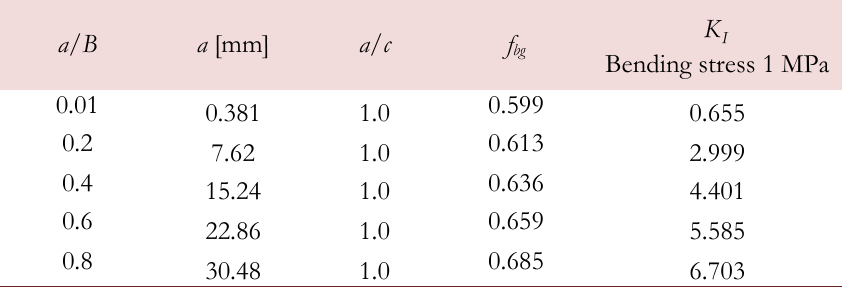
Table 2: Coefficients f bg and SIFs for a range of crack